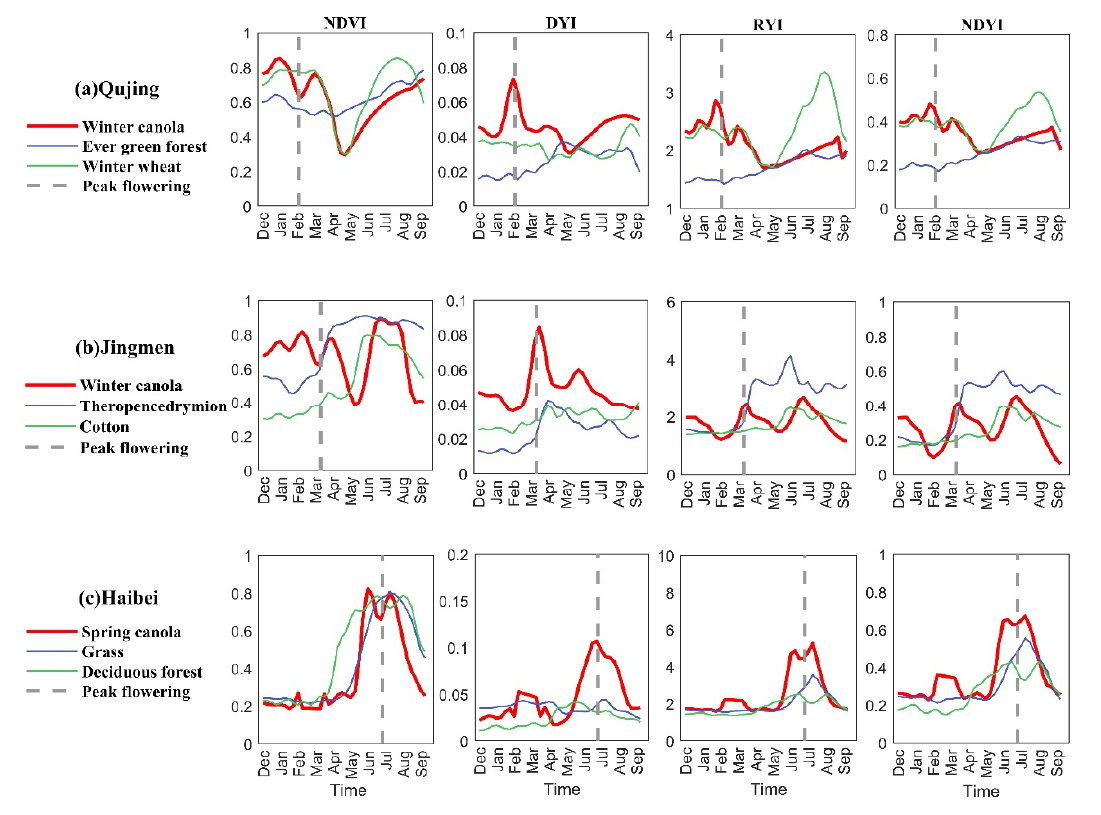
Figure 4. Time-series of NDVI, DYI, RYI, and NDYI and the actual flowering period of different land-cover types in different sites. ( a ) Qujing, ( b ) Jingmen, ( c ) Haibei.